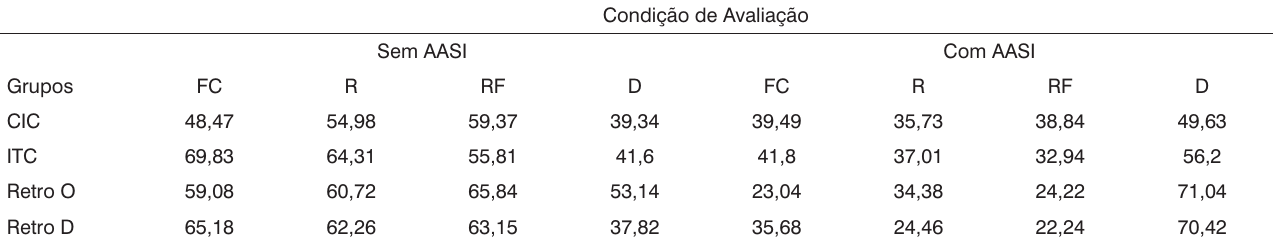
Tabela 2. Média da porcentagem de problemas obtidos sem o uso do AASI nas diferentes subescalas do questionário APHAB, para os dife- rentes grupos estudados